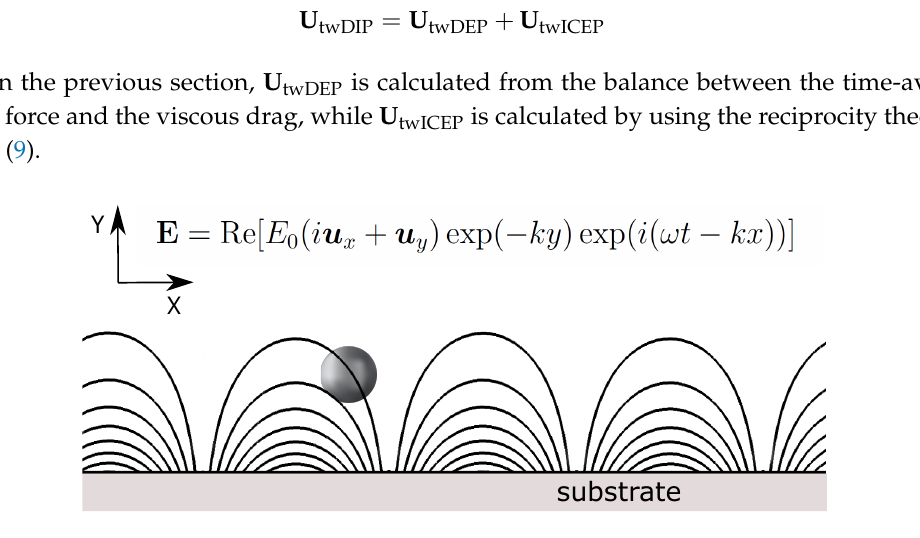
Figure 2. Metal particle subjected to a travelling electric